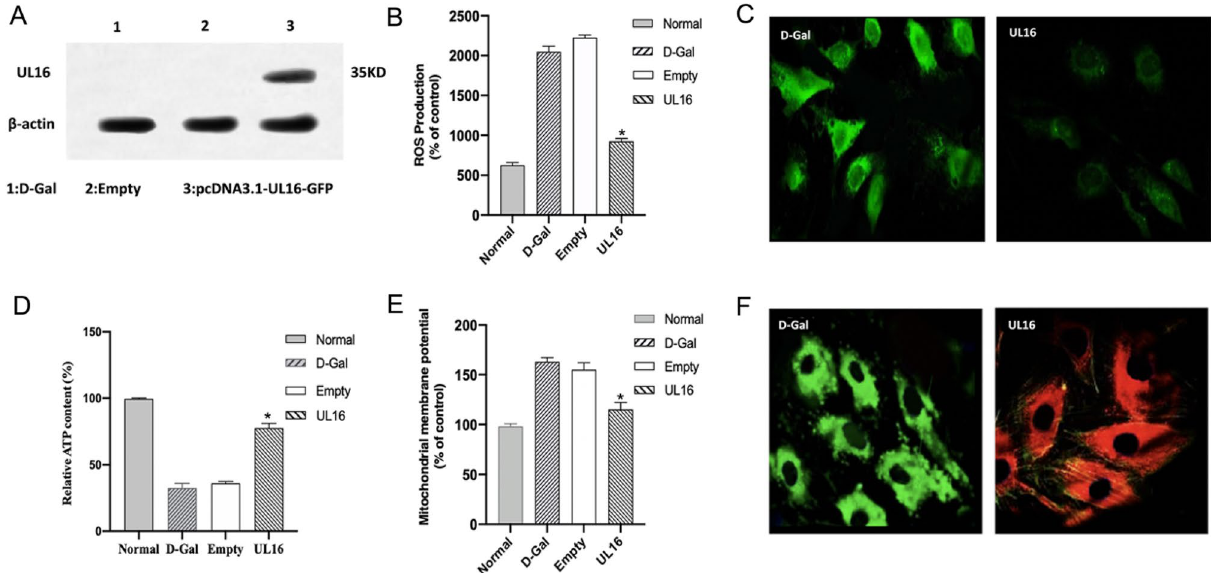
Figure 5. The mitochondrial function test of the mitochondrial damage model induced by d-Gal after UL16 transfection. ( A ) It was verified that UL16 had been successfully transfected into the HUVEC cells induced by d-Gal. ( B , C ) The intracellular ROS level was detected in d-Gal group and UL16 group. (bar.50 μm, * p < 0.05, ** p < 0.01). ( D ) UL16 was transfected into HUVEC cells induced by d-Gal, and then the content of ATP was measured in UL16 group, d-Gal group, Noraml group and Empty group. ( E , F ) The mitochondrial membrane potential of cells in d-Gal group and UL16 group was measured. electron microscope. (bar.20 μm, * p < 0.05, ** p <